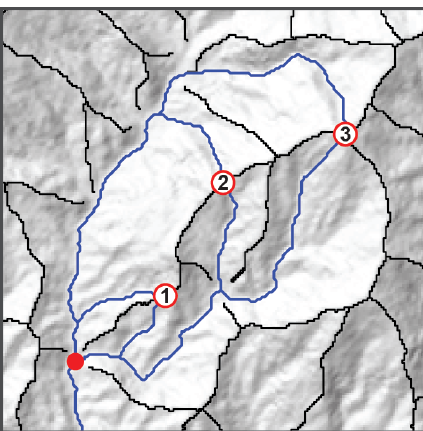
Figure 3. Ordering of divides based on the average distance to a common stream location, (cid:51) . Numbered circles are places on drainage divides (black lines), and blue lines indicate the flow path to their common stream location (red circle). The resulting order of the drainage divide places is 1 < 2 < 3. The landscape shown is part of the Big Tujunga drainage basin.